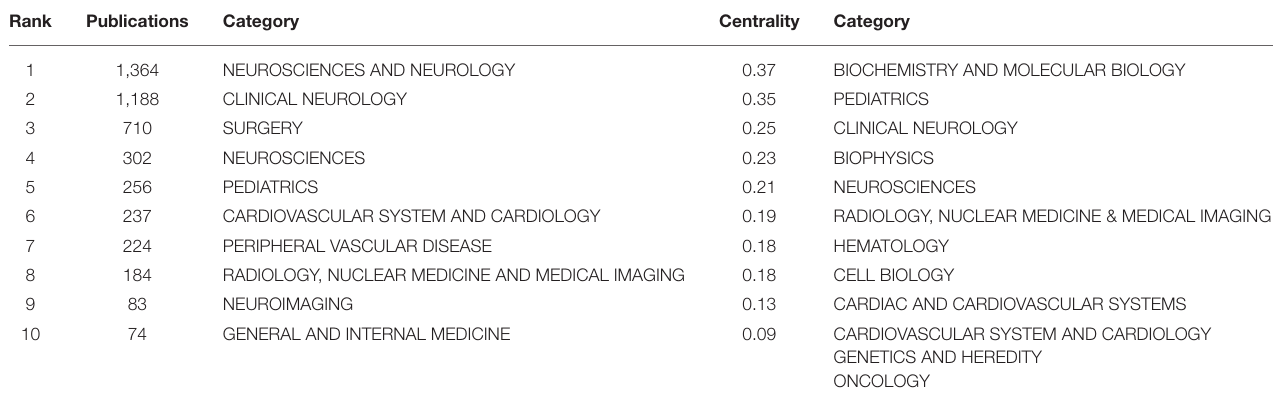
TABLE 5 | Top 10 subject categories in terms of publication number and centrality related to MMA research. Rank